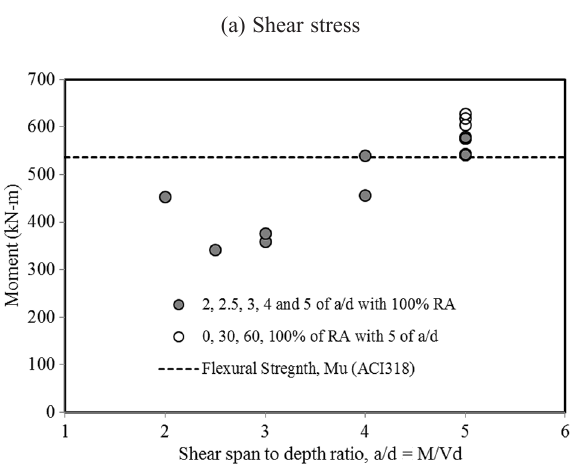
Fig. 10. Shear stress with respect to replacement levels of recycled